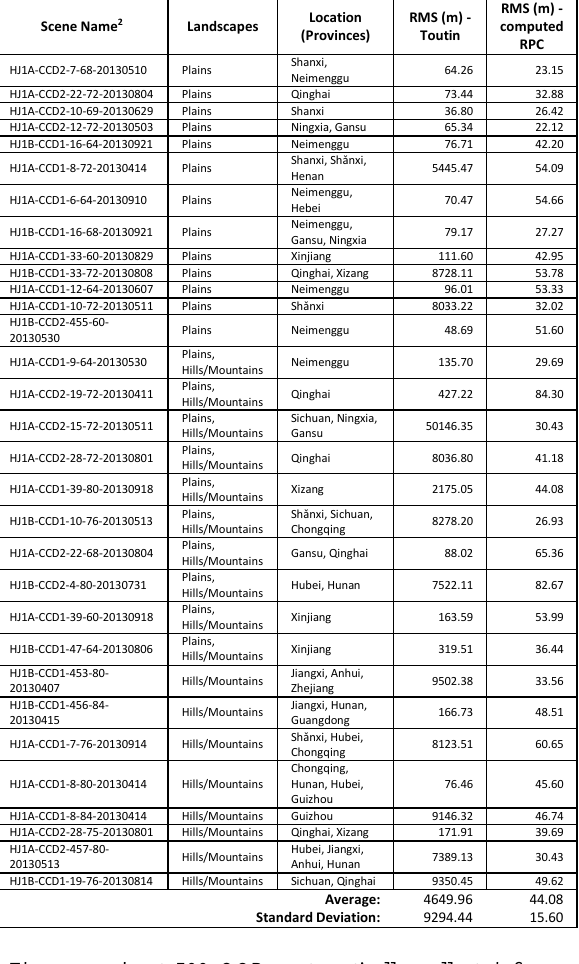
There are about 500 GCPs automatically collected for each scene against a mosaic (in the 2000’s) of the 15m Landsat 7 ETM orthos (NASA, 2014) over China. After fitting those GCPs to the simulated Toutin model and the RPC computed from those GCPs, it can be seen that the residual errors with the Toutin model at cross track are large and forms a second-order polynomial function trend, while those with the computed RPC are small and randomly distributed. See Figure 1 for the comparison. The rest of all combinations of RMS of X or Y with respect to the cross/along track show a random distribution of errors and are not shown here in order for shortening the paper.